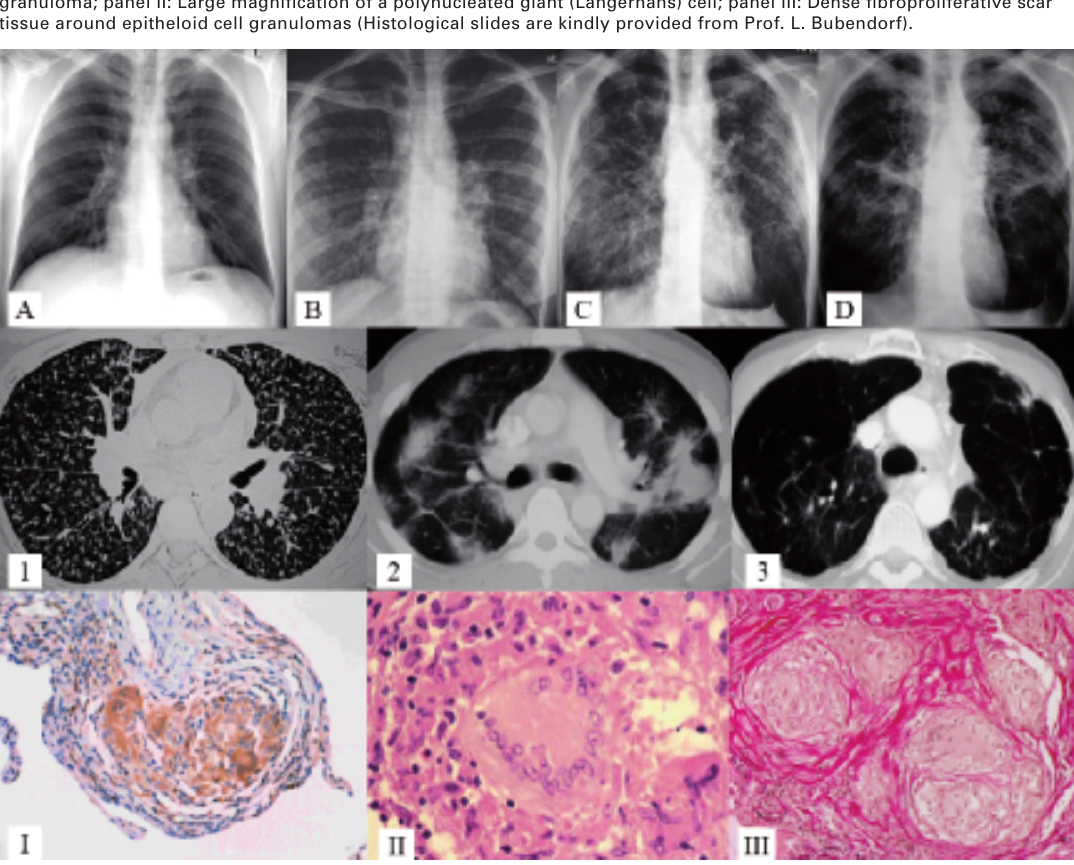
picion of disease but normal chest x-ray. In patients